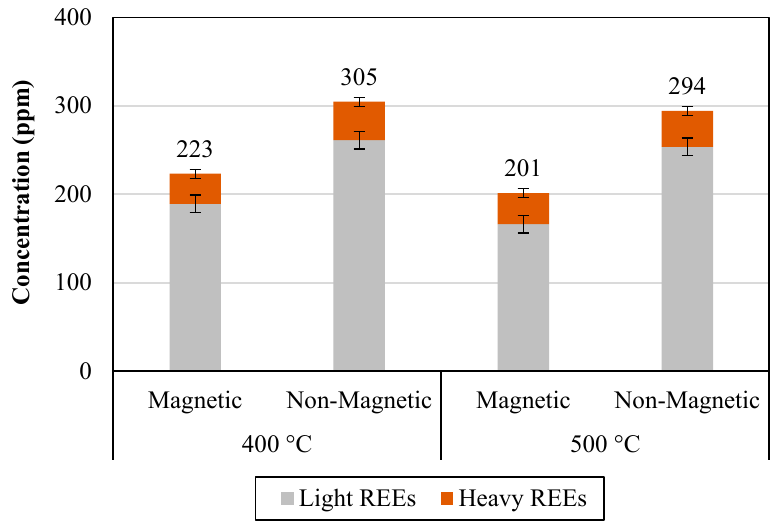
Figure 8. Mass yield of magnetic separation tests at varying magnetic field intensities for the 2.20 SG sink fraction of Baker seam coal calcined at 400 °C. Minerals 2023 , 13 , 327